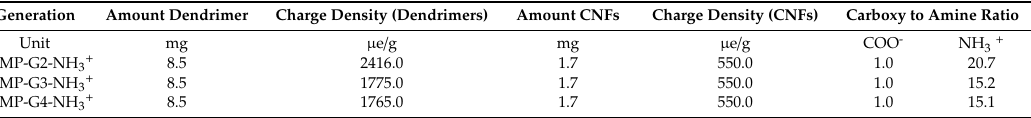
Table 1. Polyelectrolyte titration of the anionic CNFs and cationic dendrimers.